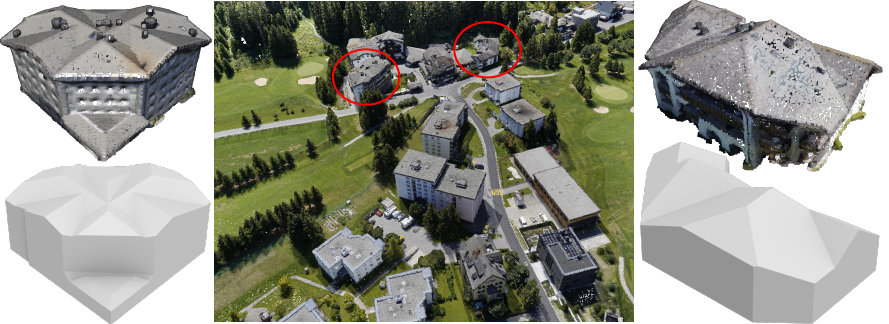
Figure 11. Reconstruction from aerial point clouds. In these point clouds, the vertical walls can be extracted from the point clouds and directly used in reconstruction, and thus the vertical plane inference step was skipped. The dataset is obtained from Can et al.